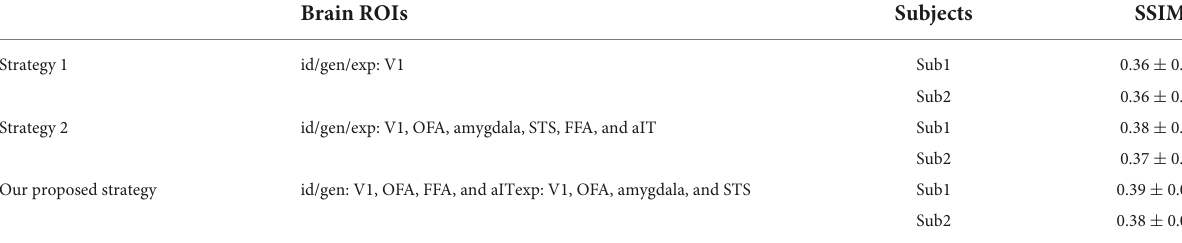
TABLE 6 Quantitative evaluation of reconstruction performance with three different ROI combination